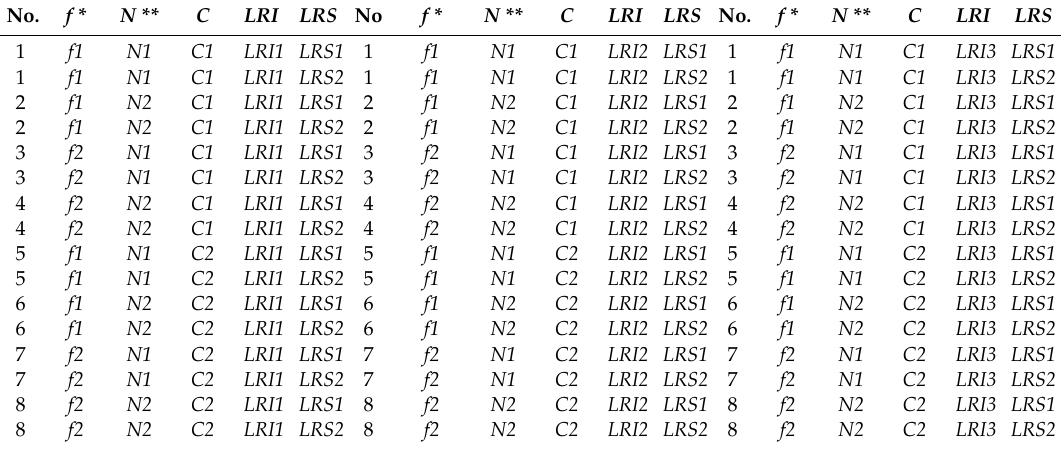
Table 2. Experimental design: product of a full factorial 2 3 and a block of two factors (3 × 2).